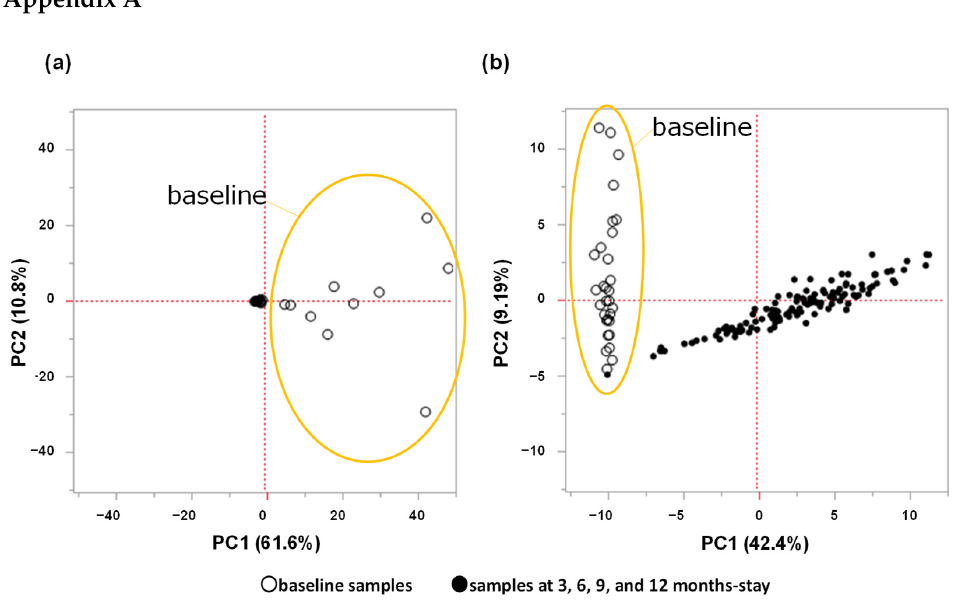
Figure A1. Score plots of the principal component (PC) analysis. The analytical results using ( a ) the peak area divided by the peak area of the internal standard and ( b ) the peak areas divided by the peak area of creatinine. PC1 and PC2 indicate the first and second PC, respectively. Contribution ratios (%) are shown in parentheses.